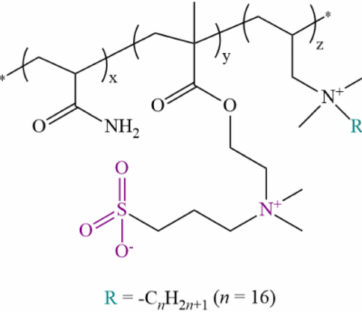
Figure 1. Molecular structure of the polymeric surfactant HAP.